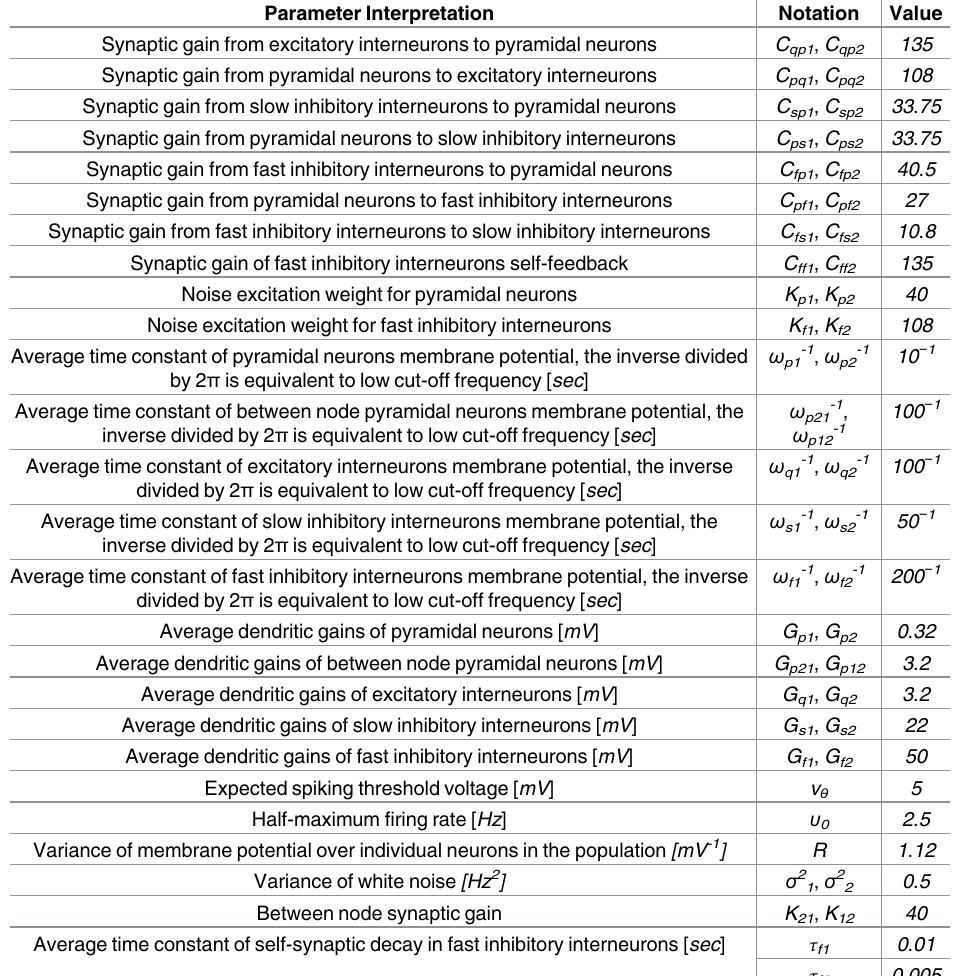
Table 1. Model parameters: Fixed